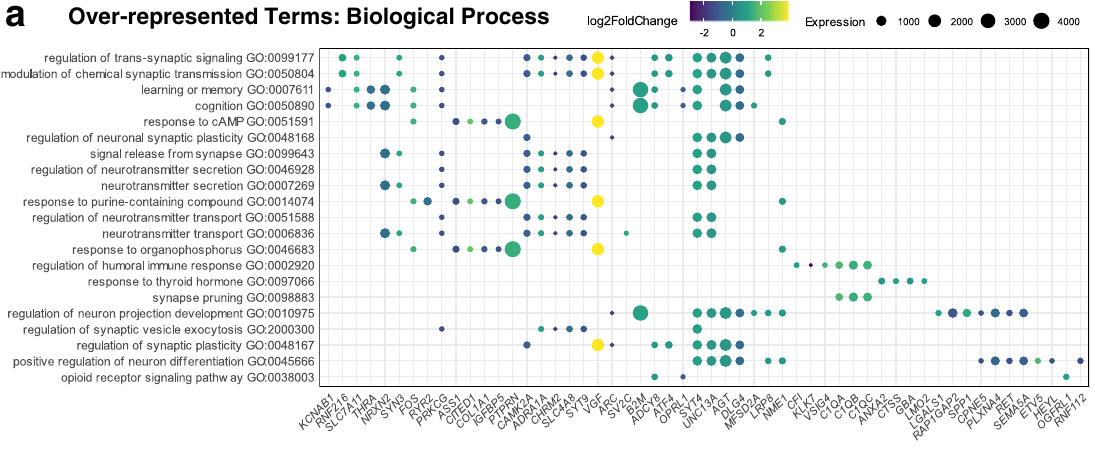
Over-represented Terms: Biological